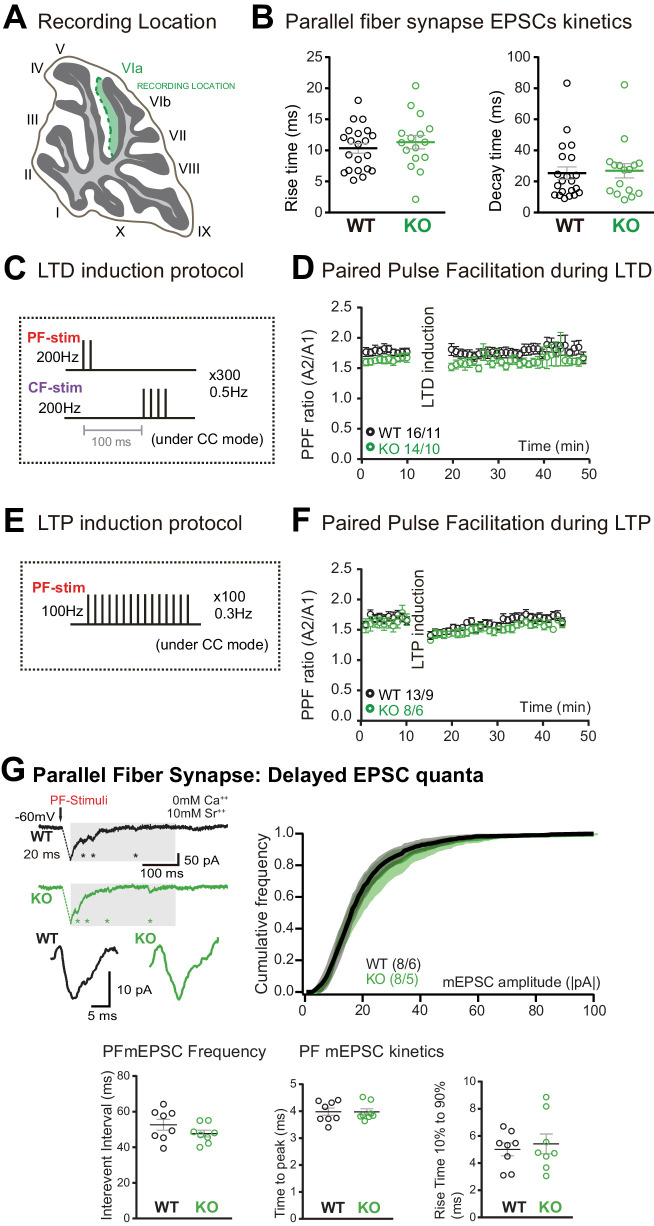
Parallel fiber (PF)/Purkinje cell (PC) synapse excitatory postsynaptic currents (EPSCs) kinetics, long-term plasticity induction protocols, paired-pulse facilitation ratio, and delayed EPSC quanta.(A) Schematic representation of the recording location (internal lobule VIa of the vermis). (B) No change in the rise time and decay of PF/PC EPSCs was induced by Susd4 deletion. Mean ± s.e.m. (wild-type [WT] n = 21 cells from eight mice and knockout [KO] n = 16 cells from six mice; rise time: unpaired Student’s t-test, p=0.4570; decay time: Mann-Whitney test, p=0.7276). (C) PF long-term depression (LTD) induction protocol. (D) Paired-pulse ratio (A2/A1) during LTD measured at 20 Hz. Mean ± s.e.m. (WT n = 16 cells from 11 mice and KO n = 14 cells from 10 mice; two-way ANOVA with repeated measures, interaction (time and genotype): p=0.9935, F(39, 1092)=0.5222). (E) PF long-term potentiation (LTP) induction protocol. (F) Paired-pulse ratio (A2/A1) during LTP measured at 20 Hz. Mean ± s.e.m. (WT n = 13 cells from nine mice and KO n = 8 cells from six mice, two-way ANOVA with repeated measures, interaction (time and genotype): p=0.9366, F(39, 741)=0.6745). (G) Delayed PF-EPSC quanta were evoked by PF stimulation in the presence of strontium (Sr++) instead of calcium (Ca++) to induce desynchronization of fusion events. Representative sample traces are presented. The cumulative probability for the amplitude shows no difference with Susd4 loss-of-function. The individual frequency values for each cell (measured as interevent interval) present no differences between the genotypes. No change in the time to peak and in the rise time of PF/PC synapse-delayed EPSC quanta was induced by Susd4 deletion. Mean ± s.e.m. (WT n = 8 cells from six mice and KO n = 8 cells from five mice; amplitude: Kolmogorov-Smirnov distribution test, p=0.1667; frequency: Mann-Whitney test, p=0.1913; time to peak: Mann-Whitney test, p=0.6454; rise time 10-90%: unpaired Student’s t-test, p=0.6486).